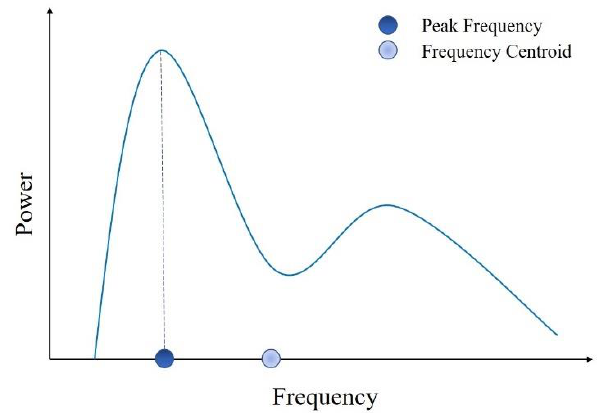
Figure 5. Configuration of peak frequency and frequency centroid.